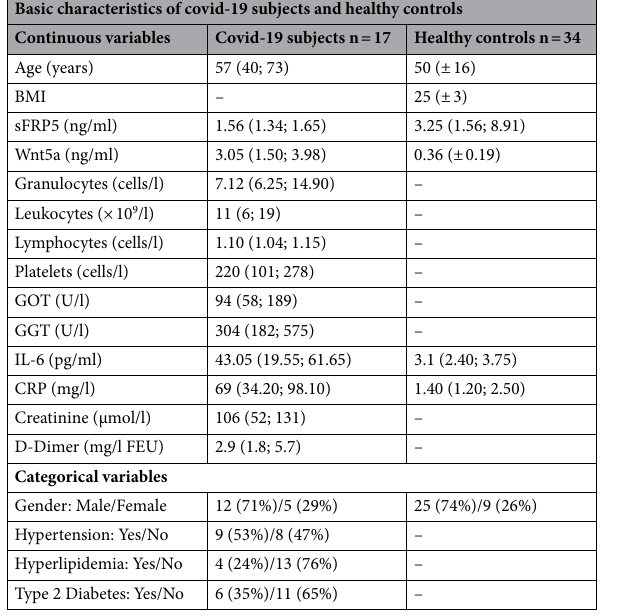
Table 3. Basic characteristics of the Covid-19 subjects from the ICU cohort and healthy controls from the FoCus cohort. Values of normal distribution are shown as mean (standard deviation), values of non-normal distribution are shown as median (25th; 75th percentile); Subjects were matched by age and gender.